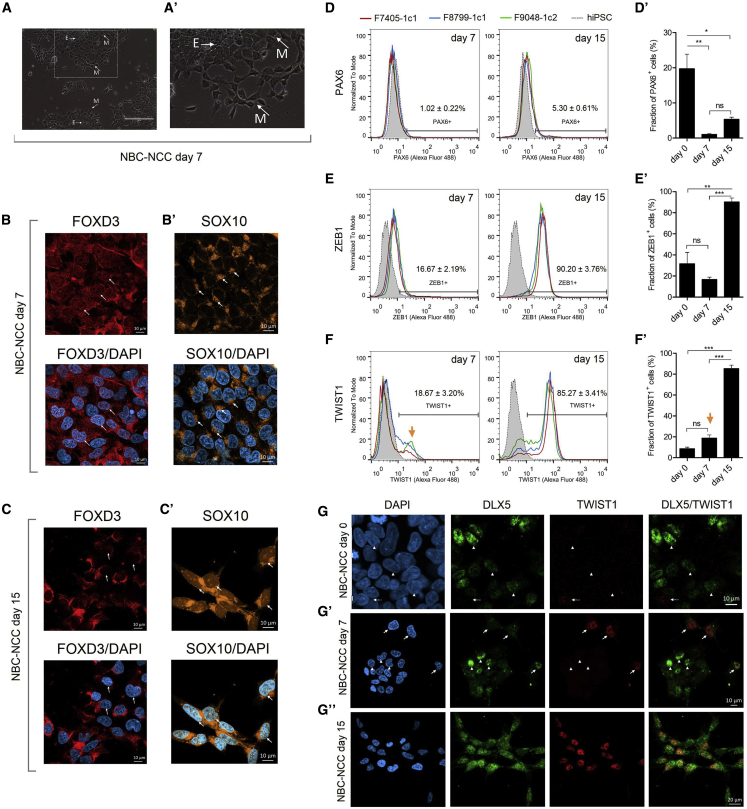
EMT Cell-State Transitions on Day 7 of NBC-NCC Induction(A and A′) Representative phase-contrast micrographs depicting morphology of day 7 NBC-NCCs; higher magnification is shown in (Aʹ). E, epithelial-like cell clusters; M, mesenchymal-like cells. Scale bar, 200 μm.(B–C′) Representative immunostaining FOXD3 and SOX10 on days 7 (B and B′) and 15 (C and C′) (n = 3 biological replicates). Arrows in (B and C) indicate nuclear expression and faint nuclear expression of FOXD3, respectively. Arrows in (B′ and C′) show perinuclear aggregates and nuclear expression of SOX 10, respectively. Scale bar, 10 μm.(D–F) Flow cytometry analysis on days 7 and 15 of induction for PAX6 (D), ZEB1 (E), and TWIST1 (F). (D′–F′) Flow cytometry results from days 7 and 15 were plotted in comparison with day 0. Data are plotted as mean ± SEM (n = 3 biological replicates); yellow arrows indicate a TWIST1+ subpopulation. ∗∗∗p < 0.001, ∗∗p < 0.01, ∗p < 0.05; ns, not significant; one-way ANOVA with Dunnet's correction.(G–G″) Representative double immunostaining analysis for DLX5xTWIST1 in NBC-NCCs on day 0; arrowheads point to DLX5+ cells; dashed arrows point to TWIST1+ cells. (G′ and G″) Representative double immunostaining for DLX5xTWIST1 on day 7 (G′), and day 15 (G″) of NBC-NCC induction (n = 3 biological replicates). Arrowheads point to DLX5+ cells; arrows point to DLX5+/TWIST1+ cells. Scale bars, 10 μm (days 0/7) and 20 μm (day 15).Related to Figure S4.